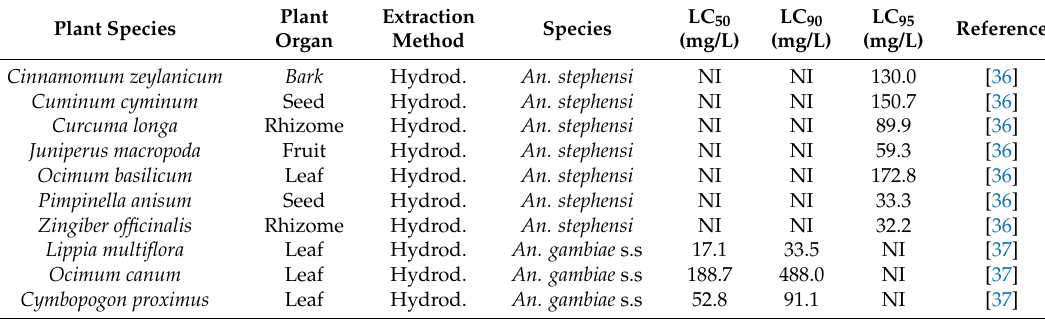
Table 1. Toxicity of essential oils against eggs of Anopheles sp .